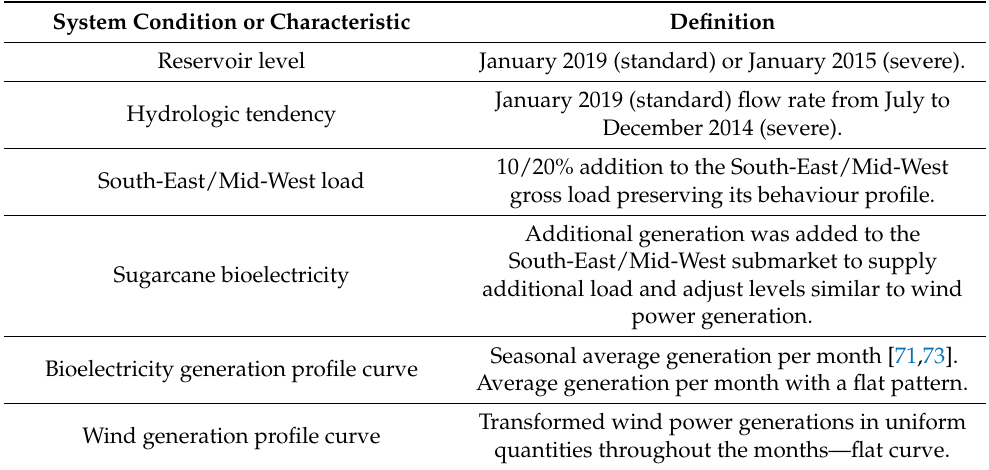
Table 3. Qualitative aspects considered in the